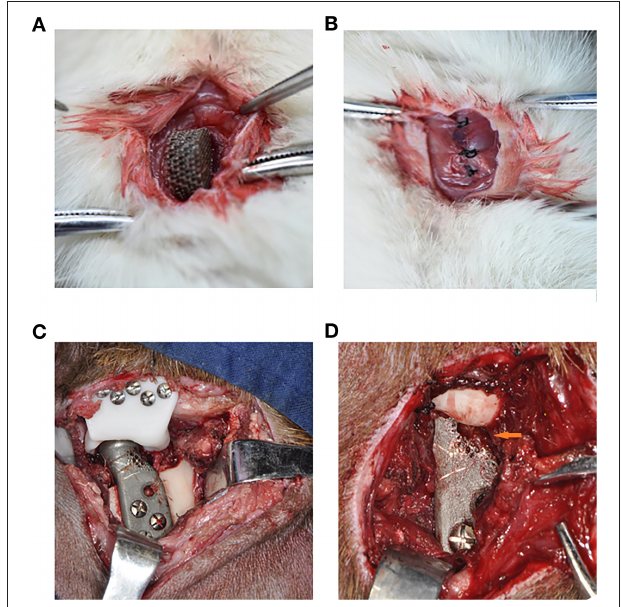
FIGURE 2 | The surgical procedure of the in vivo experiment of rats and goats. (A) The implantation of the Titanium scaffold into the intervertebral muscle. (B) The suture, make the muscle surround the scaffold completely. (C) The implantation of the porous prosthesis and fasten the LPM with 5-0 absorbable suture to the prosthesis. (D) 8 weeks after surgery, the LPM grow into the porous prosthesis (Orange arrow).